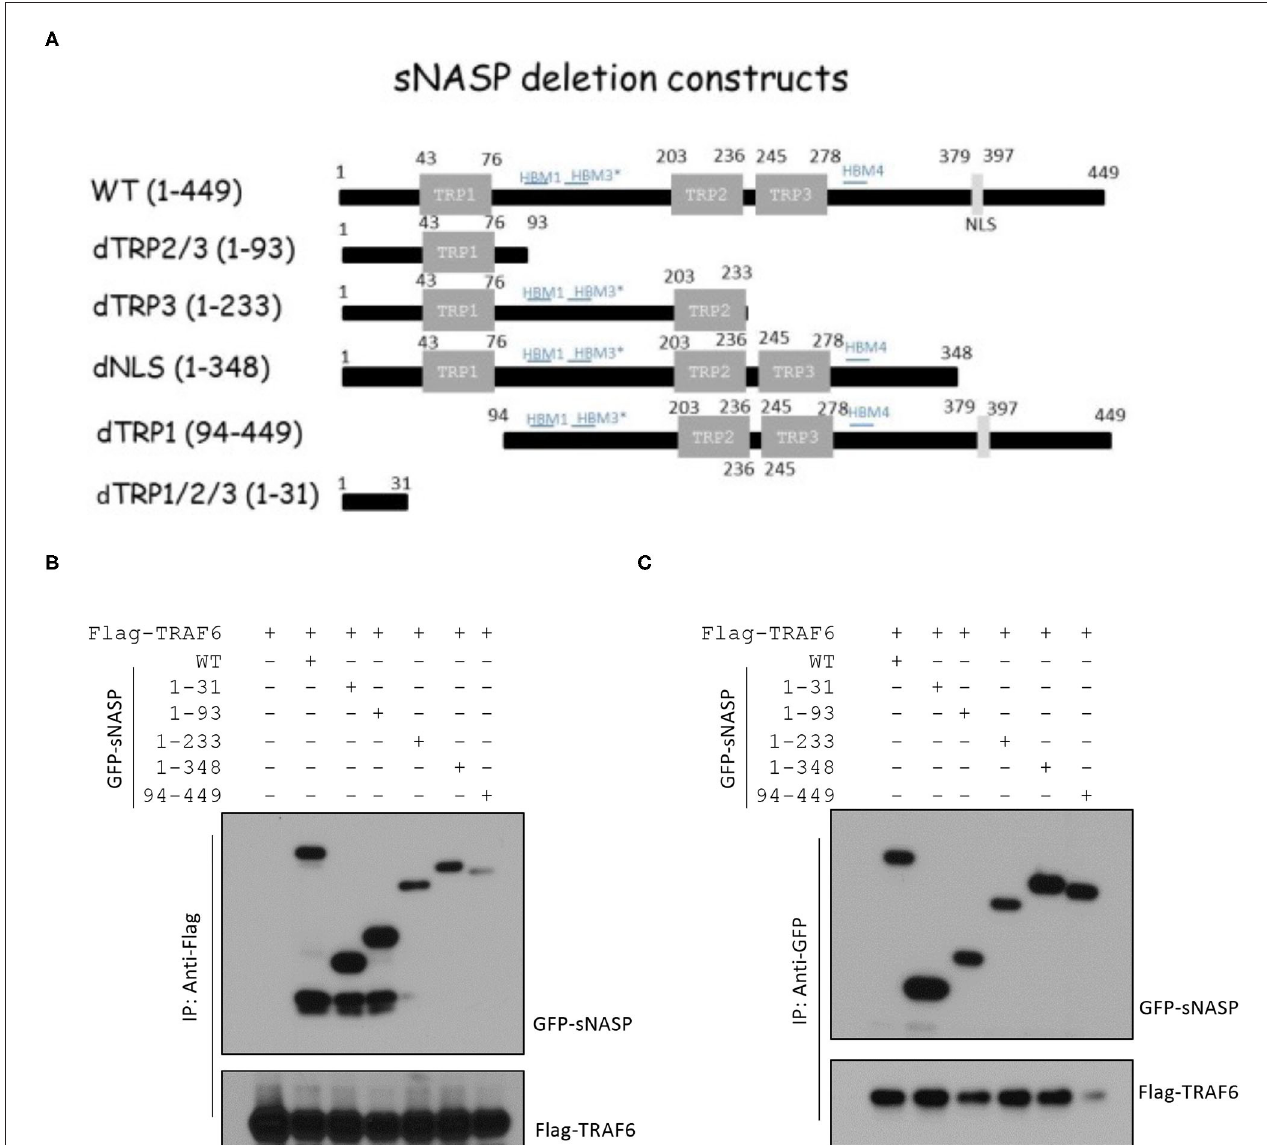
FIGURE 1 | The N-terminal 1 ∼ 31 domain of the somatic nuclear autoantigenic sperm protein (sNASP) is essential for interaction with tumor necrosis factor receptor-associated factor 6 (TRAF6). (A) Schematic representation of sNASP deletion constructs fused to the C-terminal enhanced green fluorescent protein (EGFP) tag. (B,C) Immunoprecipitation (IP) of Flag-TRAF6 (B) (with anti-Flag agarose) or GFP-sNASP (C) (with GFP-Trap) from HEK293 cells transiently transfected with GFP-sNASP wild-type or deletion mutants plus Flag-TRAF6, followed by immunoblotting (IB) with an antibody against Flag or GFP. Data represent a minimum of three independent